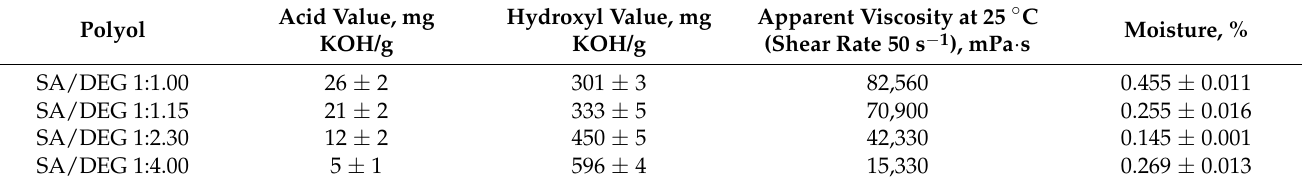
Table 6. The key characteristics of synthesized